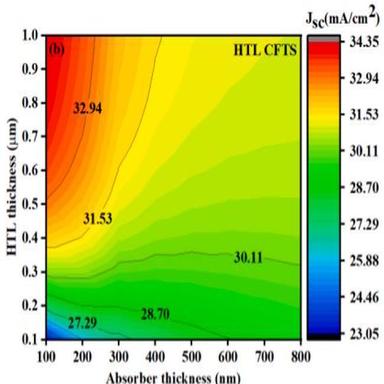
Contour mapping of Jsc for FASnI3 absorber and HTLs thickness (a) CBTS (b) CFTS (c) Cu2O (d) CuI (e) CuO (f) CuSbS2 (g) CuSCN.